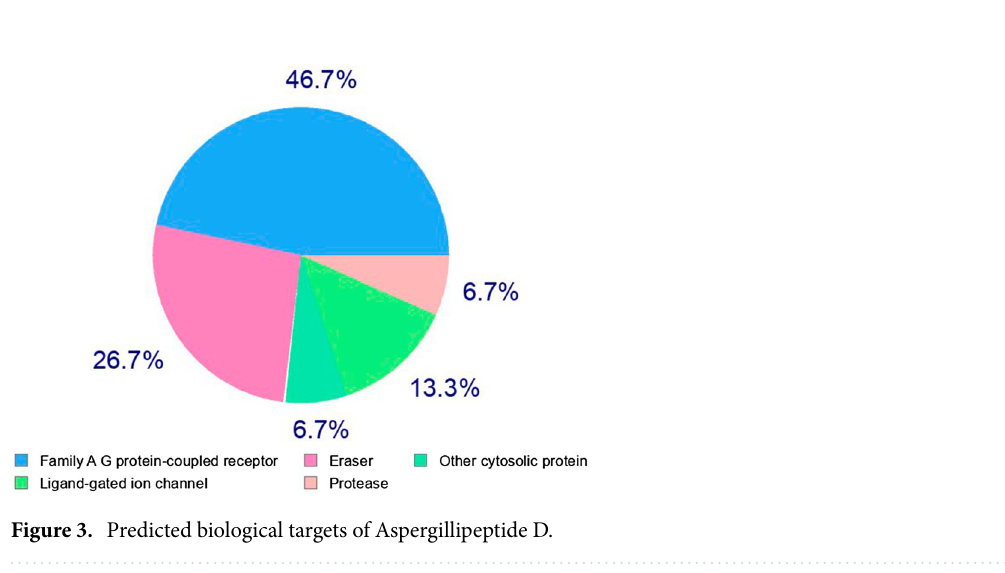
Table 2. Bioactivity scores of the Aspergillipeptide D marine cyclopentapeptide.